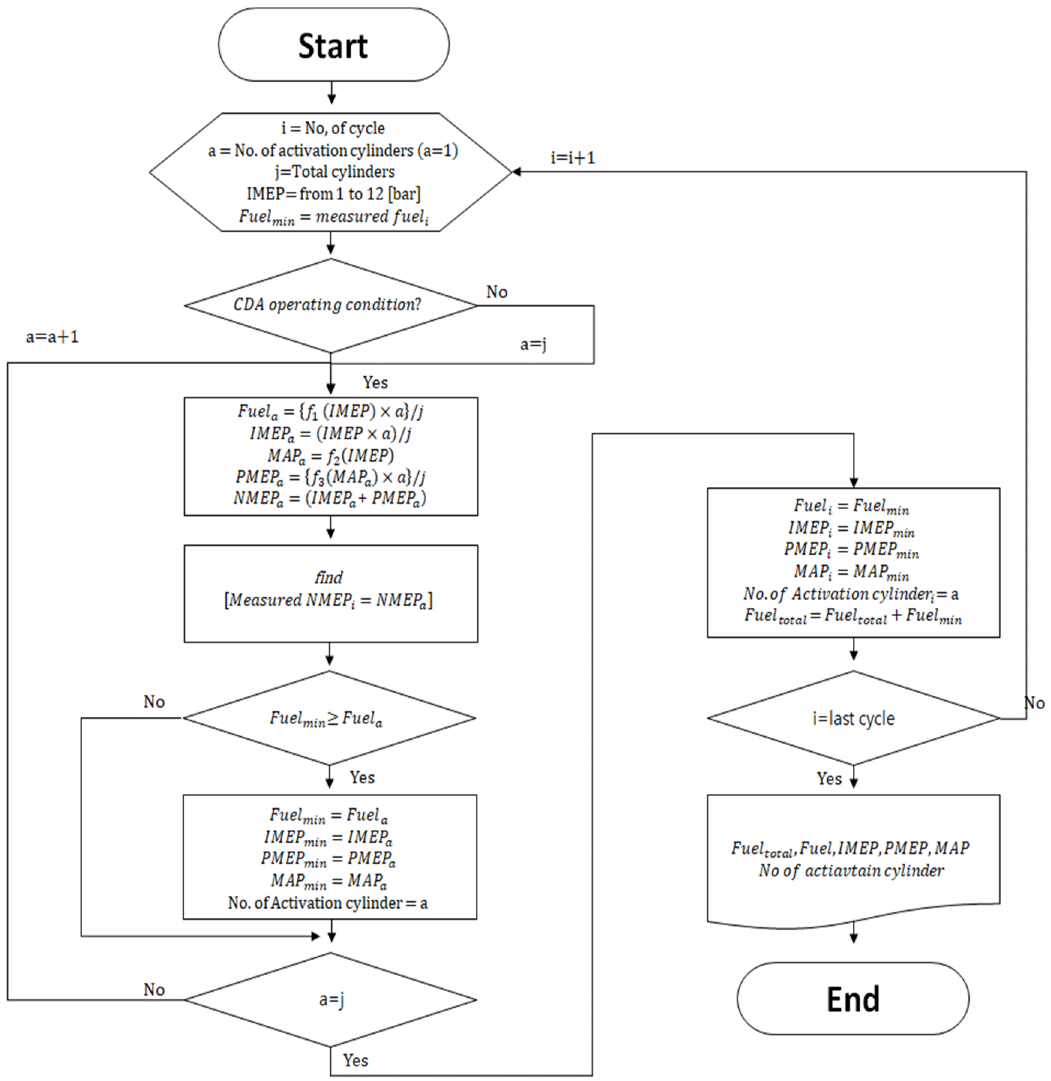
Figure 2. Flowchart of simulation.